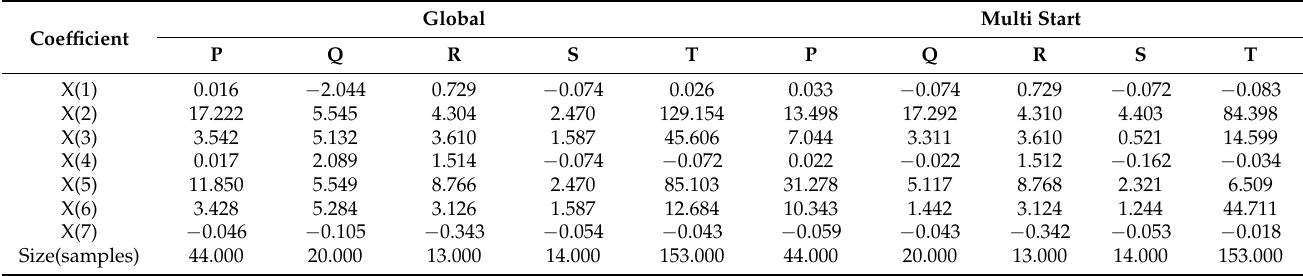
Table A2. Coefficient to fit the model with atrial premature beat (A).